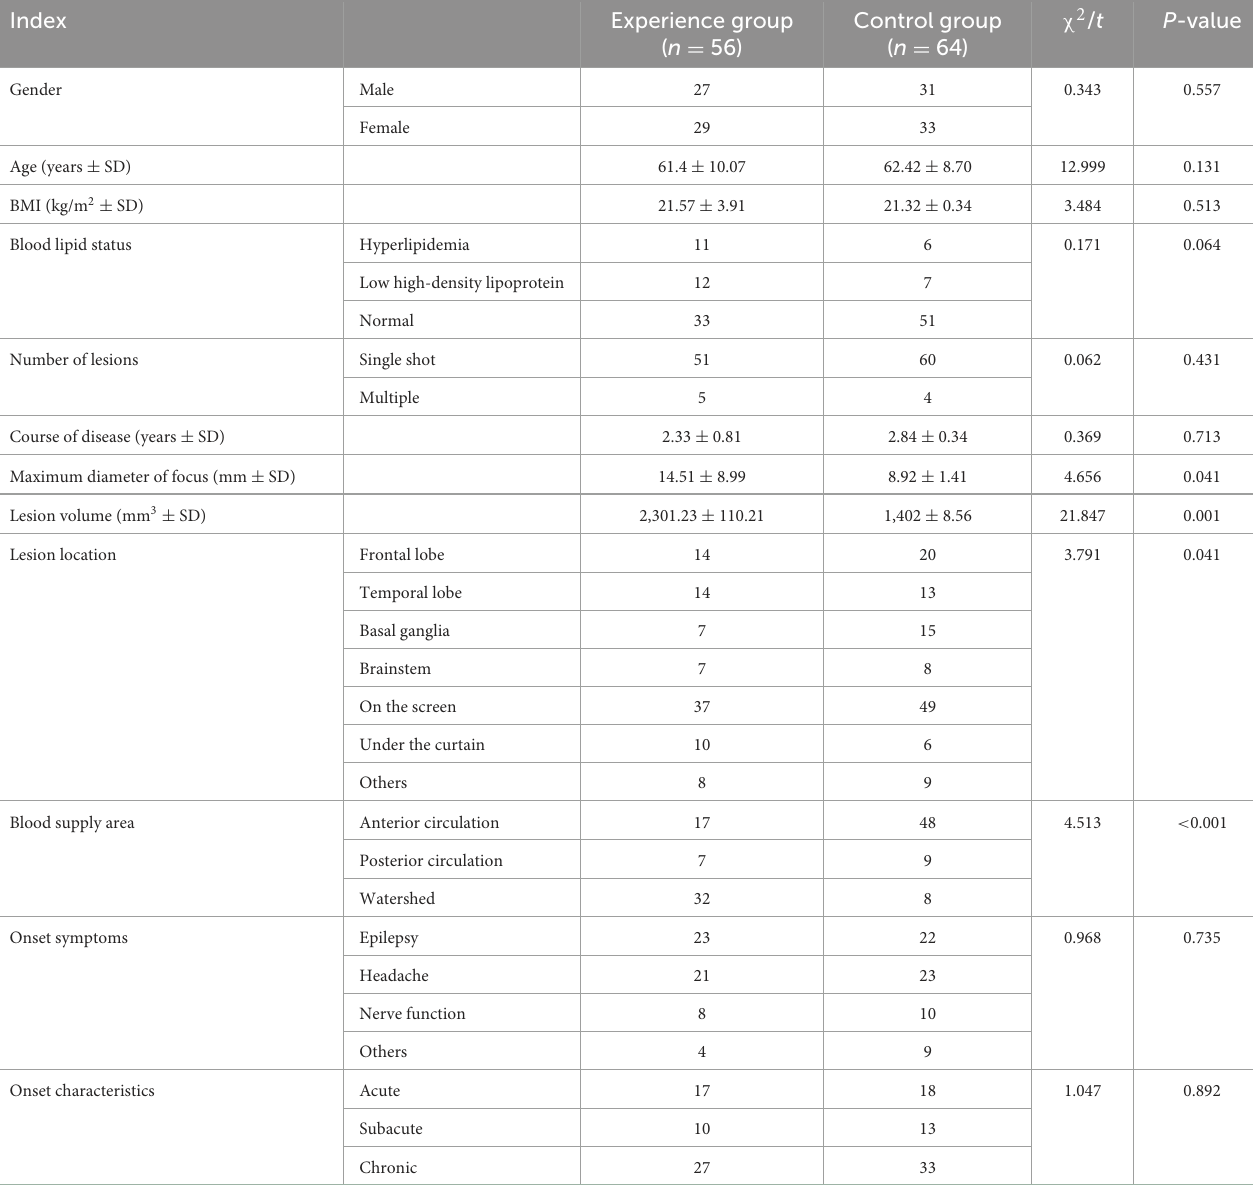
TABLE 1 Univariate analysis of ICA complicated with intracranial